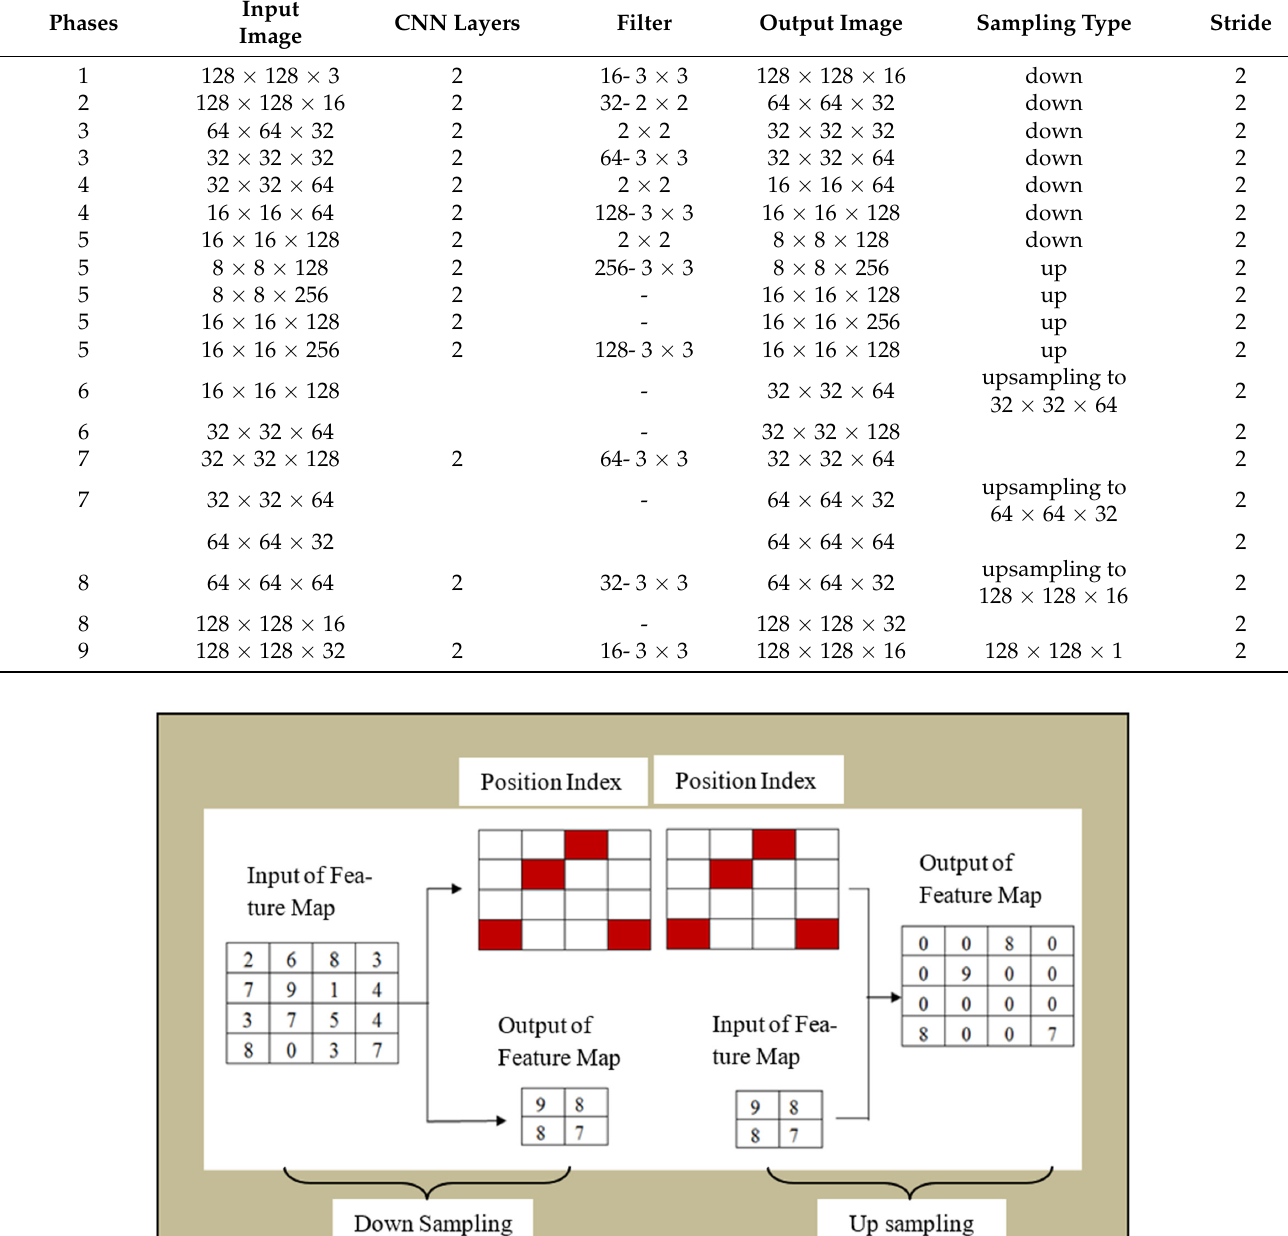
Table 2. Convolution Layers output of U-Net based Architecture.